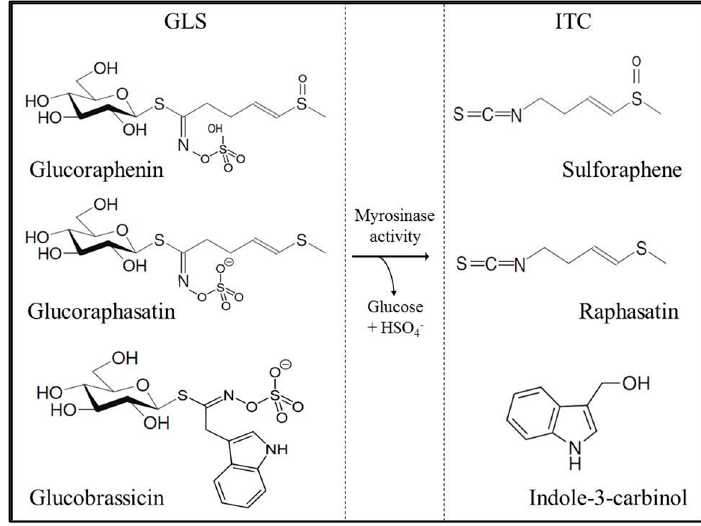
Figure 1. Glucosinolates in radish sprouts and their corresponding hydrolysis to isothiocyanates.